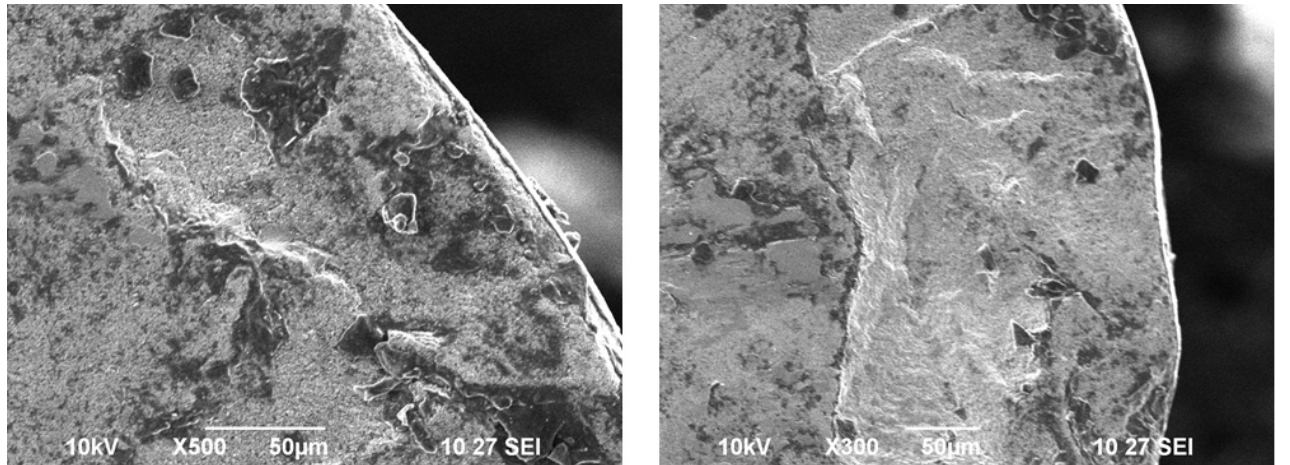
Figure 8. Wear pattern with depth of cut in turning tests.